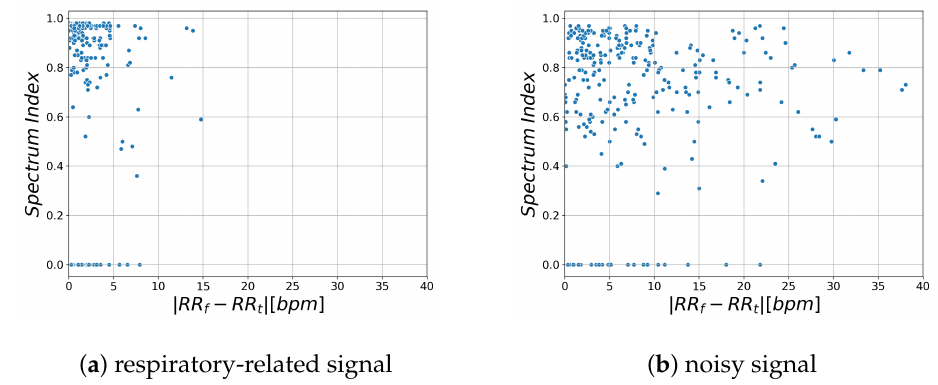
Figure 5. Verification of likelihood index: ( a ) shows signal obtained from the region where RR estimation error is lower than 1 bpm. ( b ) shows signal obtained from the region where RR estimation error is higher than 1 bpm. The x -axis represents the difference in respiratory rate [bpm] estimated from the time and frequency domains, respectively. The y -axis represents the Spectrum